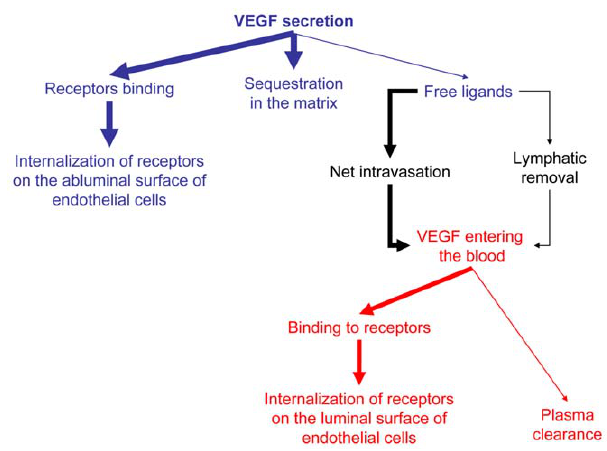
Figure 10. Summary of VEGF transport in the body. VEGF is secreted by parenchymal cells in the tissue. Most of VEGF is sequestered in the extracellular matrix or binds to the abluminal receptors and disappears by VEGF-bound receptor internalization. A small fraction (free VEGF) is transported from the available interstitial fluid to the plasma (mostly through the permeability route rather than by the lymphatics). Upon entering the blood, free VEGF either binds to luminal receptors and disappears by VEGF-bound receptor internalization or is cleared from the plasma.